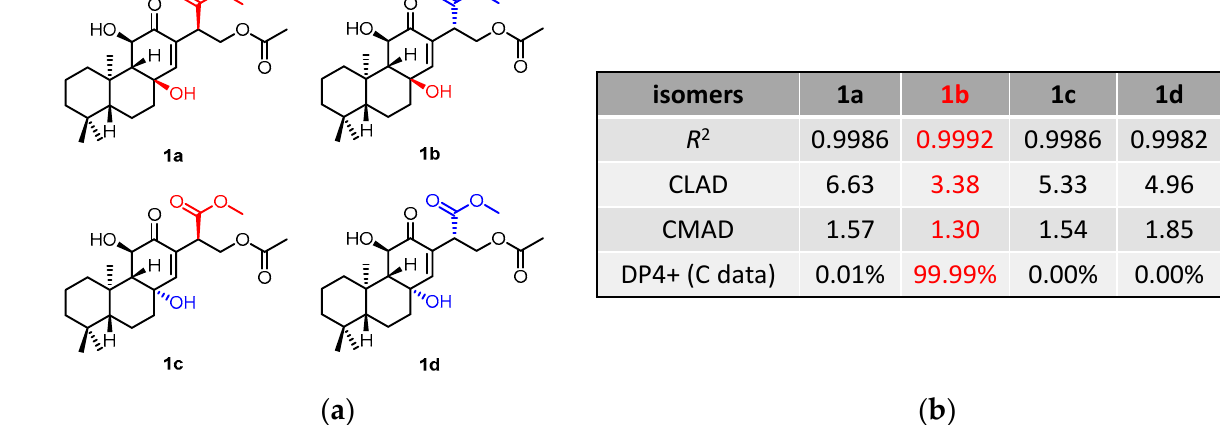
Figure 4. 13 C NMR calculation results of compound 1 at the mPW1PW91/6-311+G(d,p) level. ( a ) Structures of conformer 1a ‒ 1d . ( b ) Key parameters of the calculated chemical shifts of conformers 1a ‒ 1d .